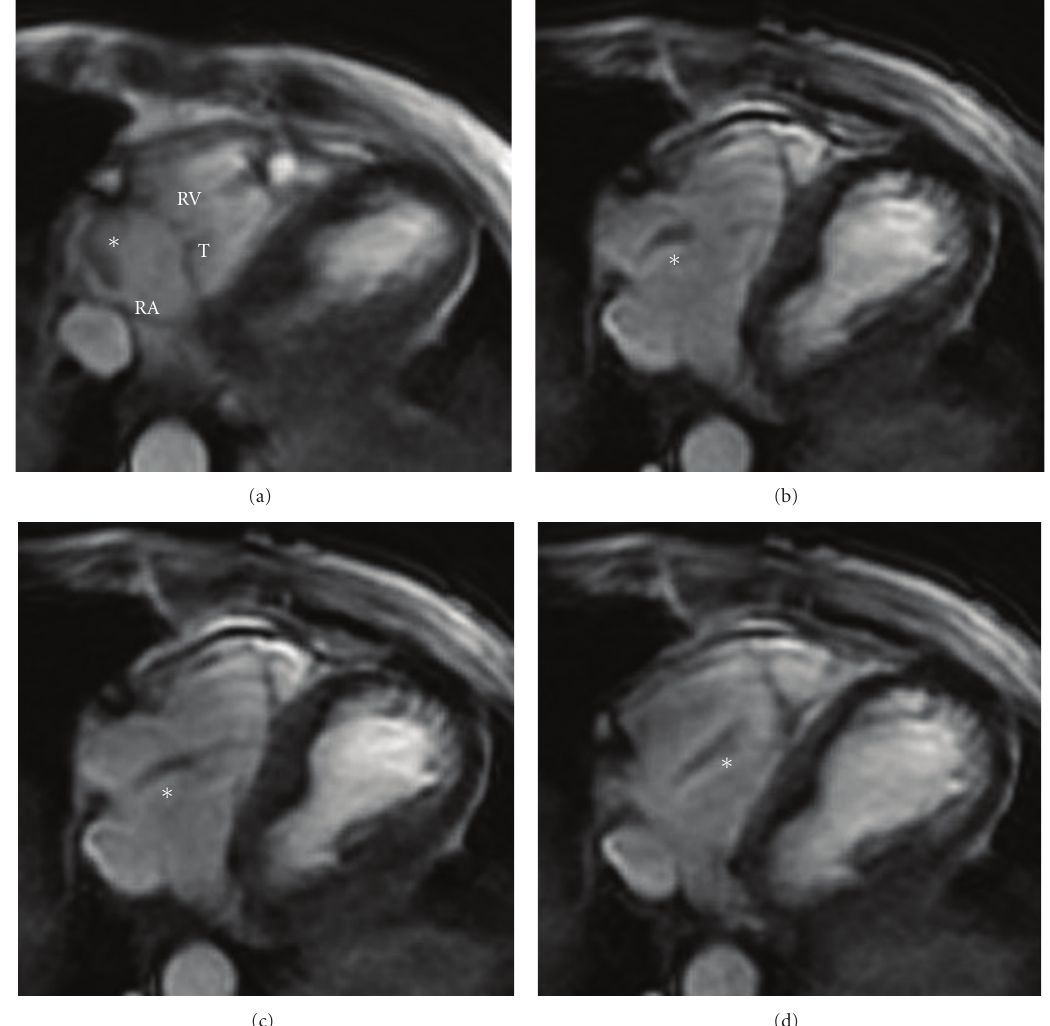
Figure 4: MRI. Sequence of the movement of the thrombus ( ∗ ) in the right heart. During the systole is “rolled” in RA (a), in isovolumic diastole “lengthens” ((b), (c)) to then prolapse in RV, in end-diastole